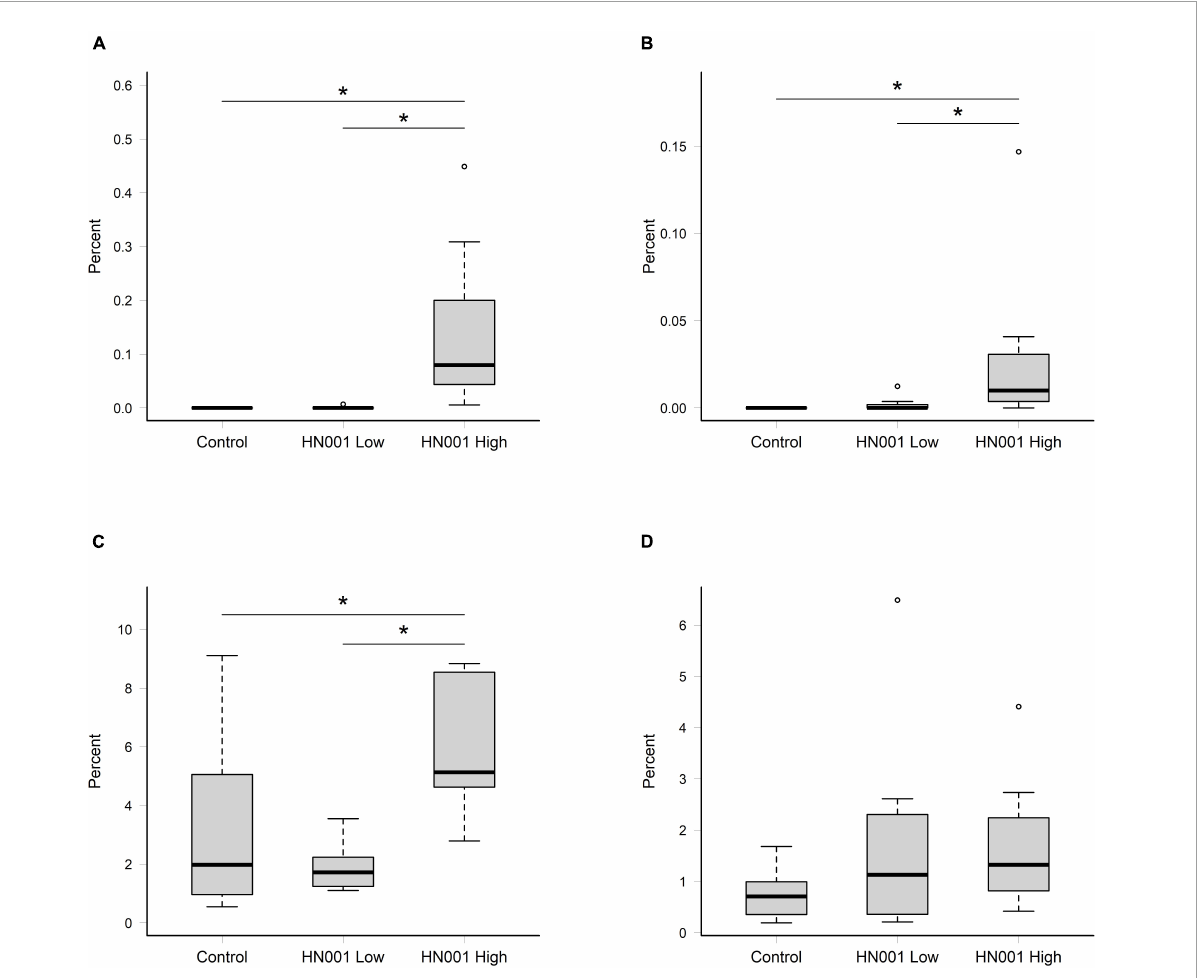
FIGURE1 Relative abundances of reads assigned to Lacticaseibacillus rhamnosus in (A) cecal and (B) fecal samples, and the collective relative abundances of reads assigned to L. rhamnosus and uncultured and unclassified Lactobacillus in in (C) cecal and (D) fecal samples. Significant differences indicated by asterisk (permutation ANOVA P < 0.01). Boxplots indicate median (middle line), first and third quartile (boundaries of box), 1.5 times the interquartile range (whiskers), and outliers